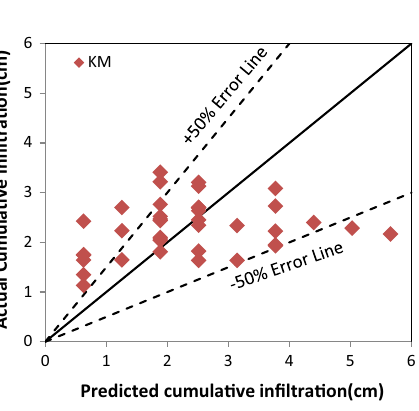
Fig. 9 Actual values versus predicted values of cumulative infiltration for the SCS model and Kostiakov model of the testing dataset